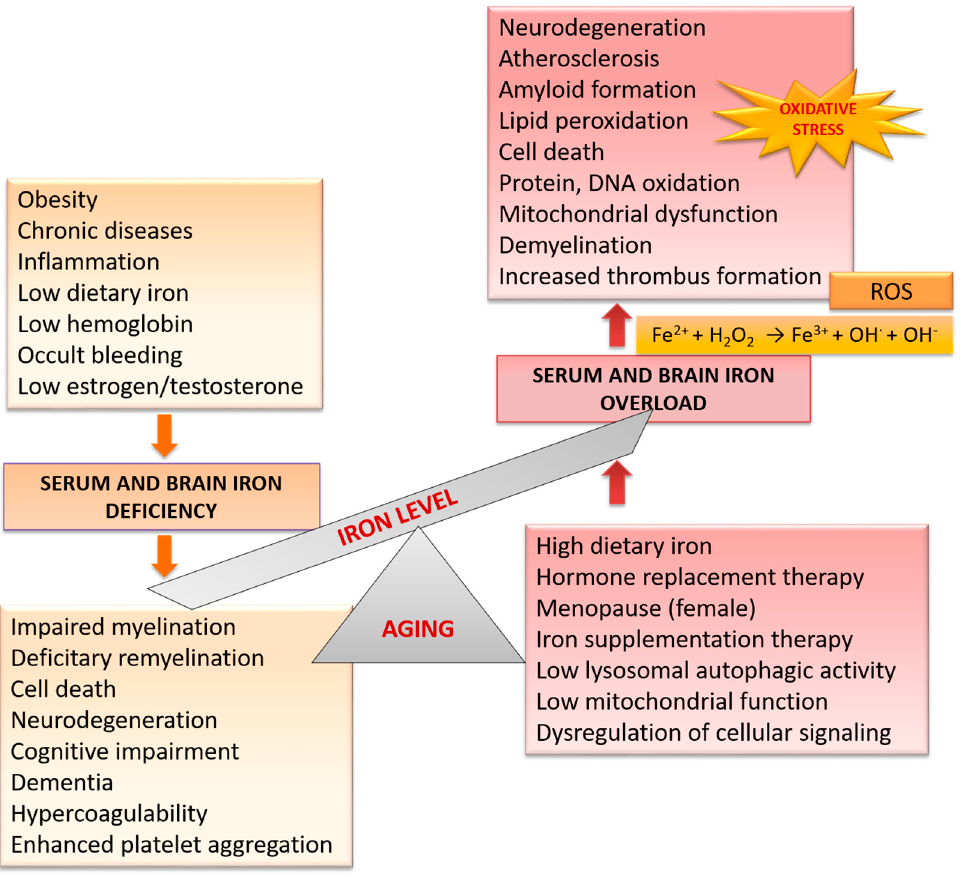
Figure 2. Age-related changes in iron level and consequent brain disorders.